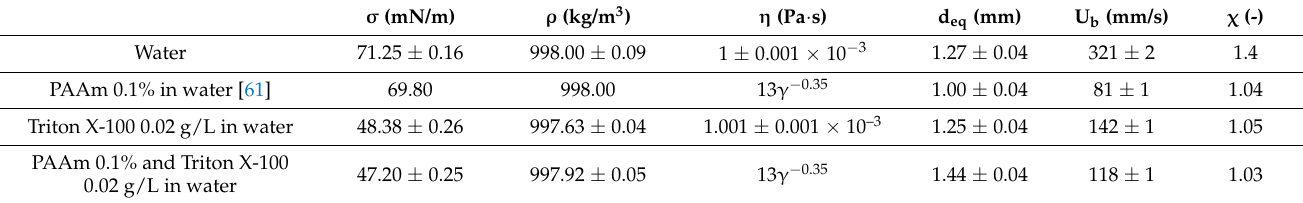
Table 1. Physical properties of fluids and hydrodynamic parameters of